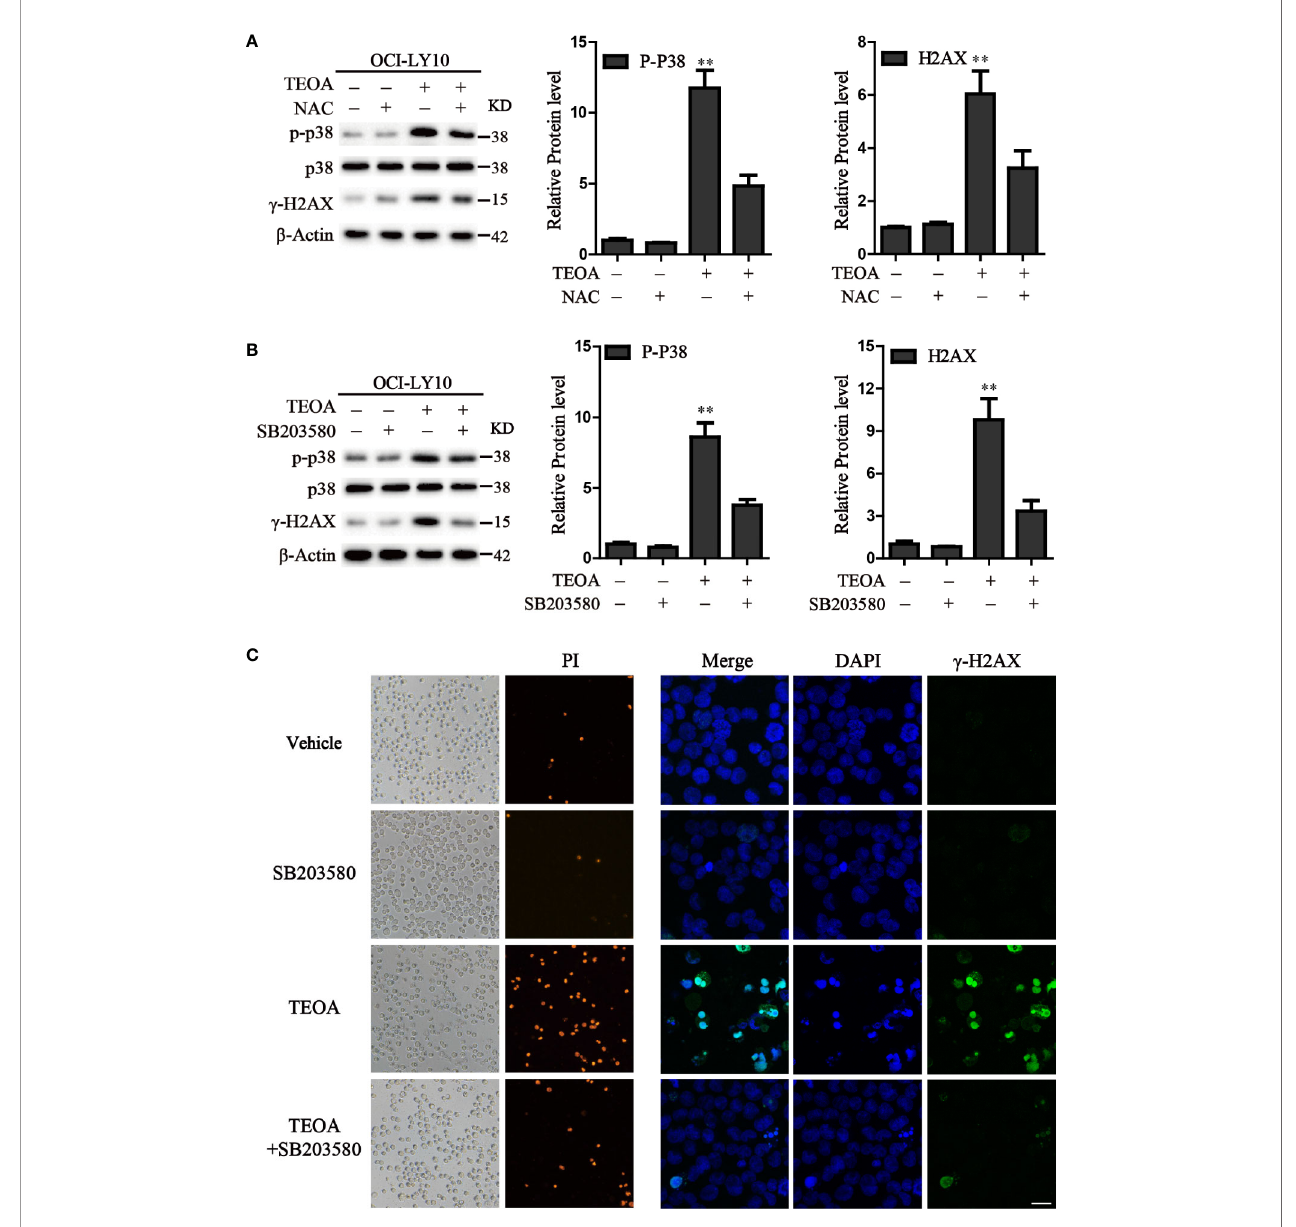
FIGURE 6 | Inhibition of ROS accumulation and p38 activation suppressed apoptosis induced by TEOA. (A) OCI-LY10 cells were exposed to TEOA for 12 h with or without NAC (5 mM) pretreatment for 1 h, the levels of p-p38, total p38, and g -H2AX were determined by western blot. The expression of p-p38 and g -H2AX was quanti fi ed by Image J software. Data were presented as mean ± SD, ** P <0.01. (B) OCI-LY10 cells were exposed to TEOA for 12 h with or without SB203580 (10 m M) incubation in advance for 1 h, the levels of p-p38, total p38, and g -H2AX were determined by western blot. Corresponding expression analysis of p-p38 and g -H2AX were shown on the right. Data are presented as mean ± SD, ** P <0.01. (C) OCI-LY10 cells were treated with 25 µM TEOA for 12 h with or without SB203580 (10 m M) pretreatment for 1 h and stained with PI or g -H2AX (1:200) primary antibody and FITC-labeled Goat Anti-Rabbit IgG (H+L) (1:500) secondary antibody. DAPI was used for nucleus staining. Images were acquired with a confocal laser scanning microscopy; scale bar: